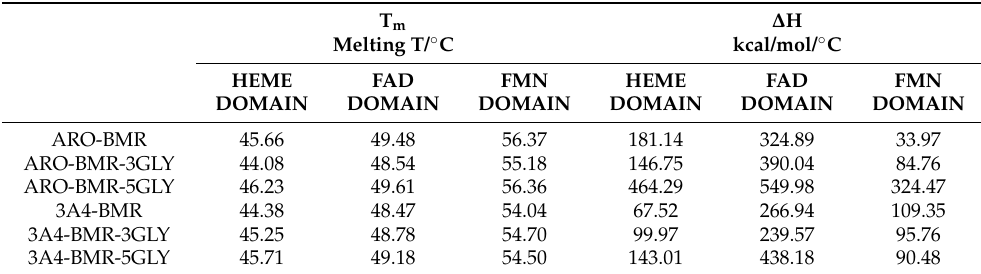
Table 2. ARO-BMR and 3A4-BMR chimeras melting temperature (T m ) values and enthalpies ( ∆ Hcal). The standard error of mean is not reported in Table 2 because it is below 1.5% of each of the reported